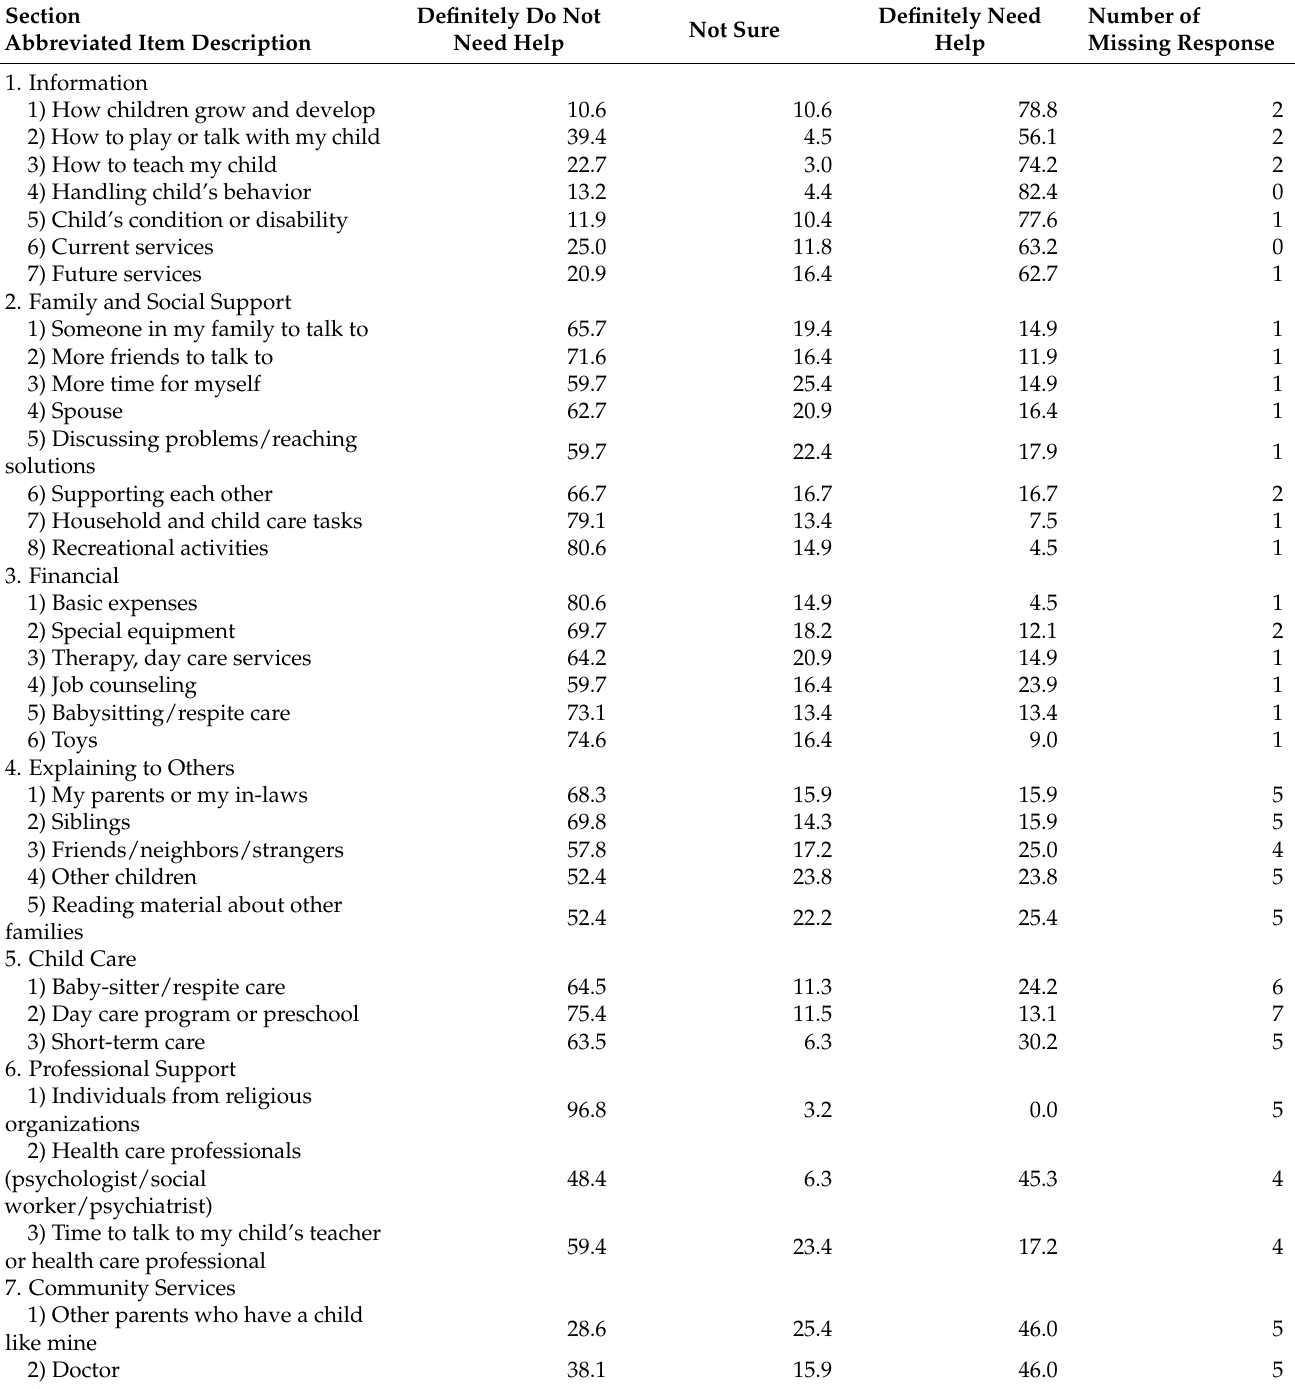
Table 1. Effective percentages of responses and numbers of missing responses according to item for all parents (N =